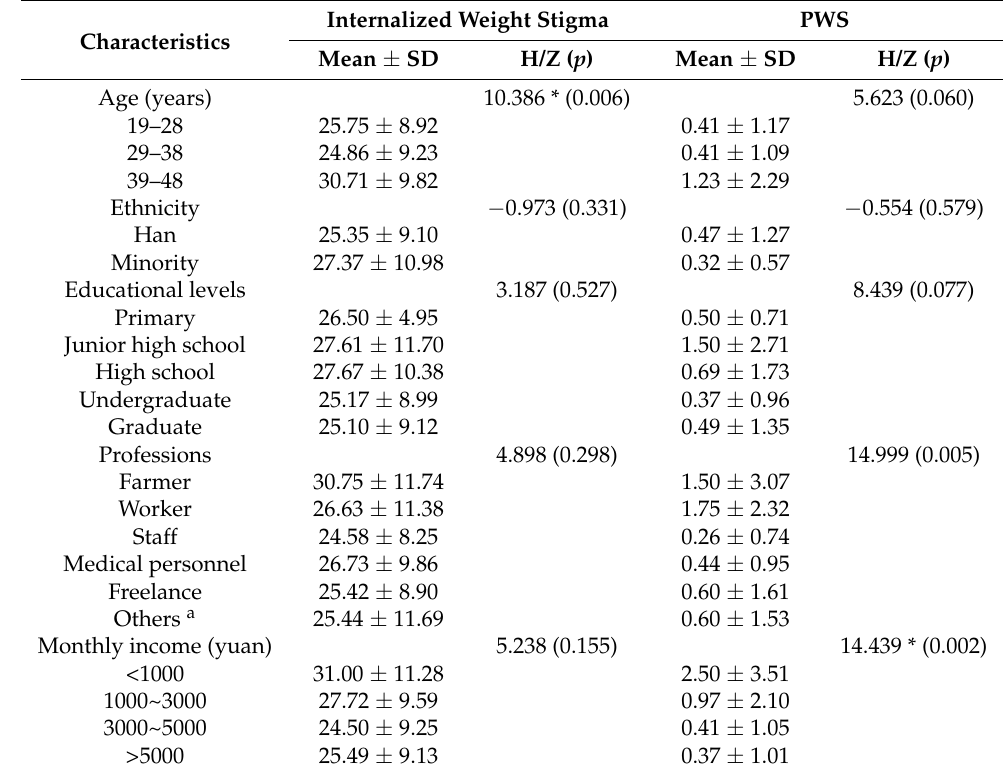
Table 4. Univariate Analysis of PWS and Internalized WS ( n = 507).